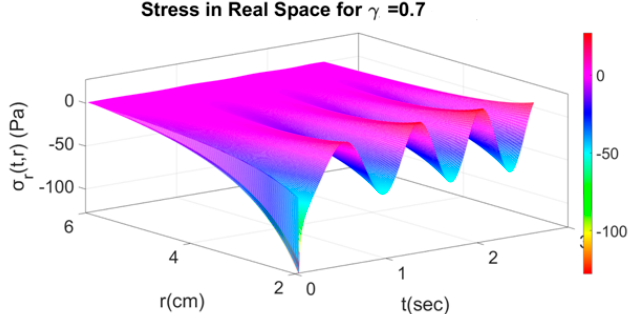
Figure 8. Distribution of the radial stress σ r ( t , r ) in the initial space for γ = 0.7.